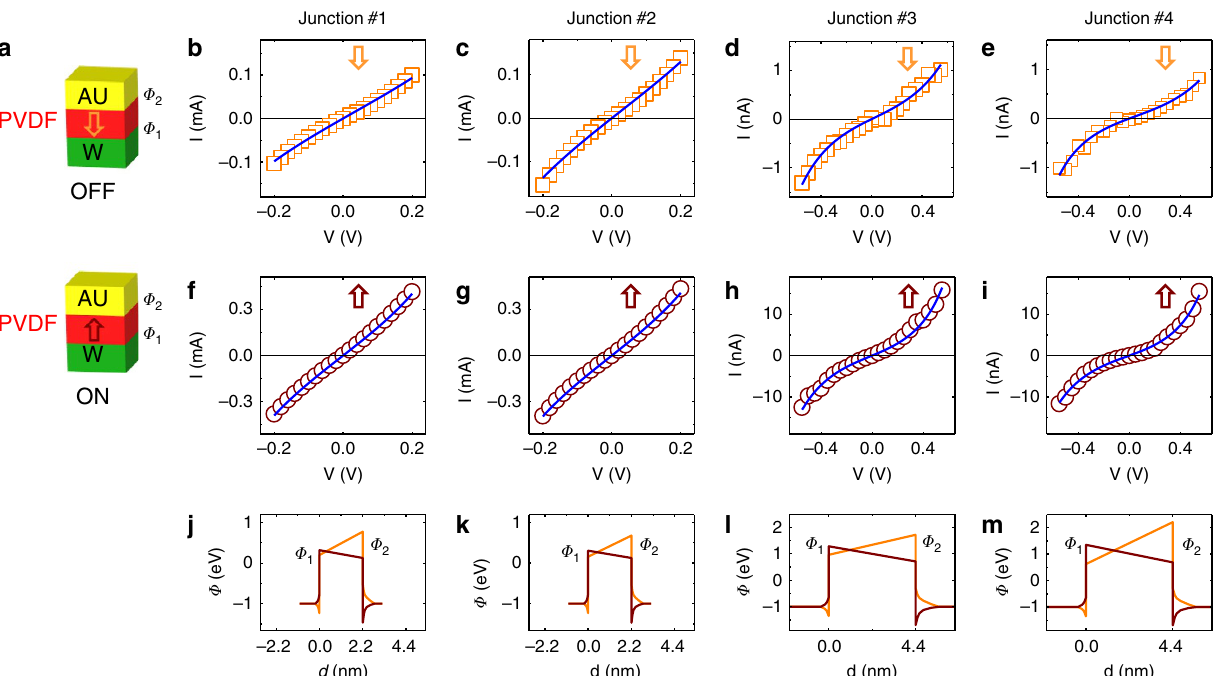
Figure 4 | Direct quantum-mechanical tunnelling mechanism in Au/PVDF/W junctions. ( a ) Sketch of the two polarisation configurations of the junctions with the corresponding ‘on’ and ‘off’ resistance states. ( b – e ) I – V curves in the downward polarisation state for junctions #1, #2, #3 and #4. ( f – i ) I – V curves in the upward polarisation state for junctions #1, #2, #3 and #4. Solid lines in b – i are fits from the direct tunnelling model. ( j – m ) Calculated electron potential profiles in both polarisation configurations (orange and brown lines for downward and upward polarisations, respectively) for junctions #1, #2, #3 and #4. Junctions #1 and #2 are based on 1L-thick PVDF and junctions #3 and #4 for are based on 2Ls-thick